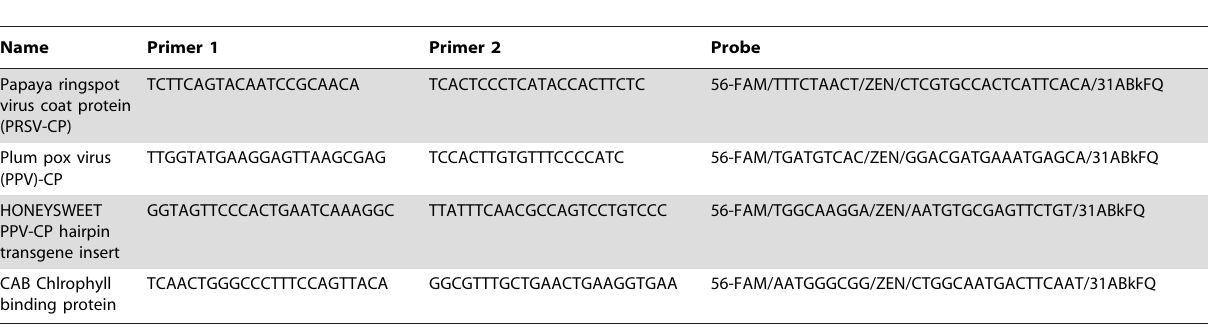
Table 1. Primer and probe combinations for analysis of pollen parent of transgenic